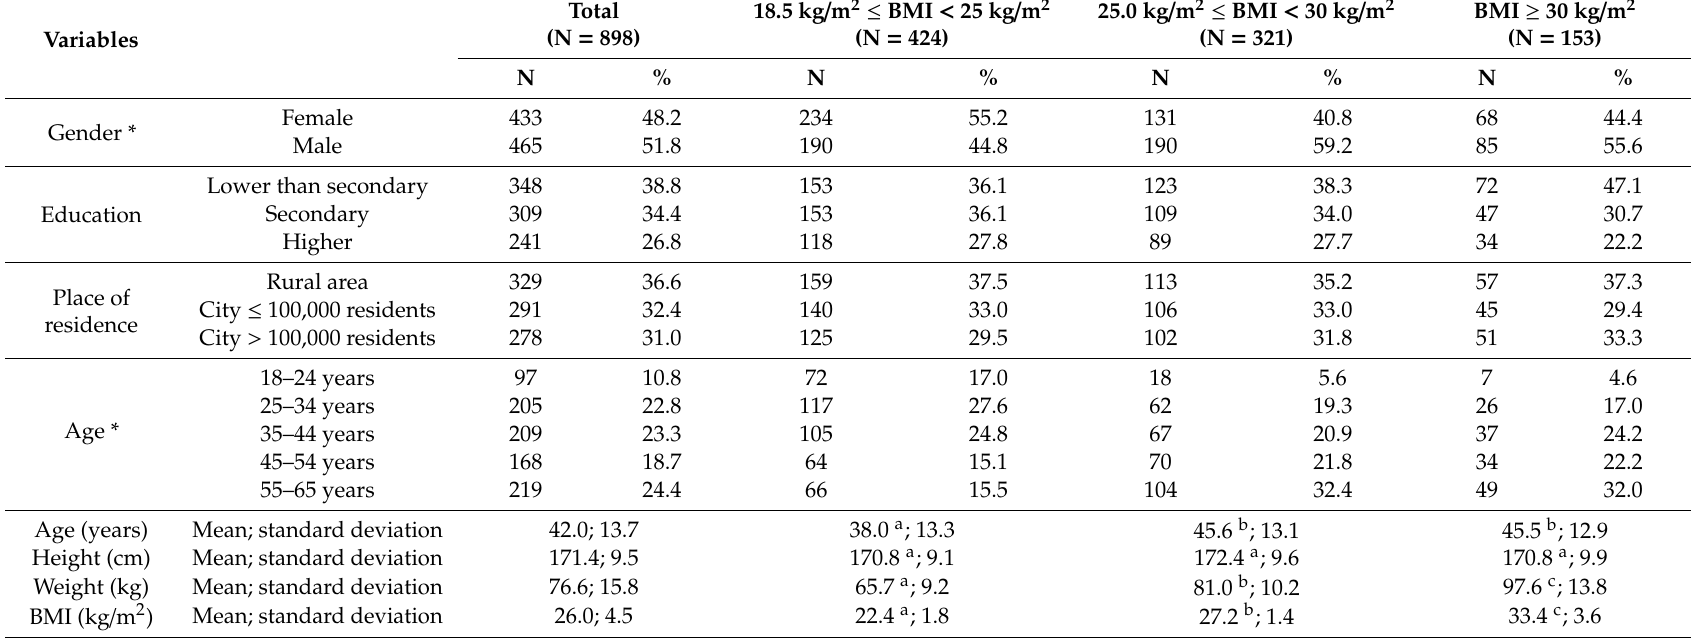
Table 2. Characteristics of the study